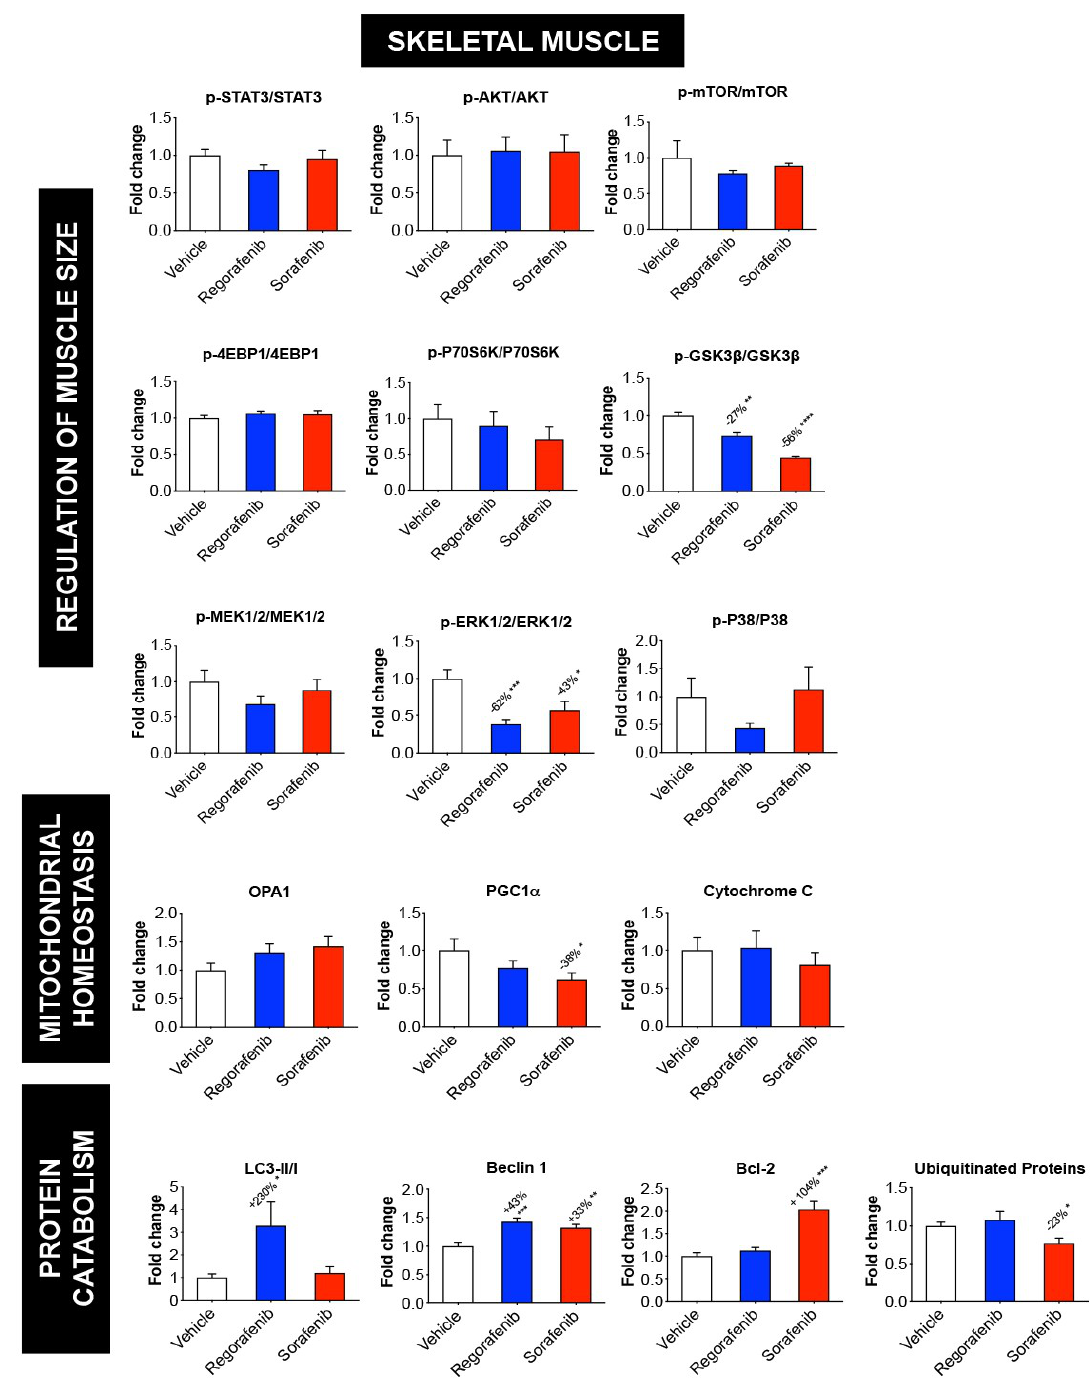
Figure 4. MKIs determine skeletal muscle atrophy. Representative western blotting and quantification (expressed as fold change vs. Vehicle) of proteins involved in the regulation of muscle size (STAT3, AKT, mTOR, 4EBP1, P70S6K, GSK3β, P38, MEK1/2, ERK1/2) (Top), proteins involved in mitochondrial homeostasis (OPA1, PGC1α, Cytochrome C) (Middle), and protein markers of autophagy-dependent catabolism (LC3, Beclin 1, Bcl-2 and total ubiquitinated proteins) (Bottom) in whole skeletal muscle protein extracts from mice treated with 30 mg/kg/day regorafenib (blue; n = 8), 60 mg/kg/day sorafenib (red; n = 8), or vehicle (white; n = 8) over the course of 6 weeks. Levels of phosphorylated proteins were normalized to their respective total protein. Tubulin served as the loading control. Data presented as mean ± SEM. Significance of the difference: * p < 0.05, ** p < 0.01, *** p < 0.001, **** p < 0.0001 vs. Vehicle.